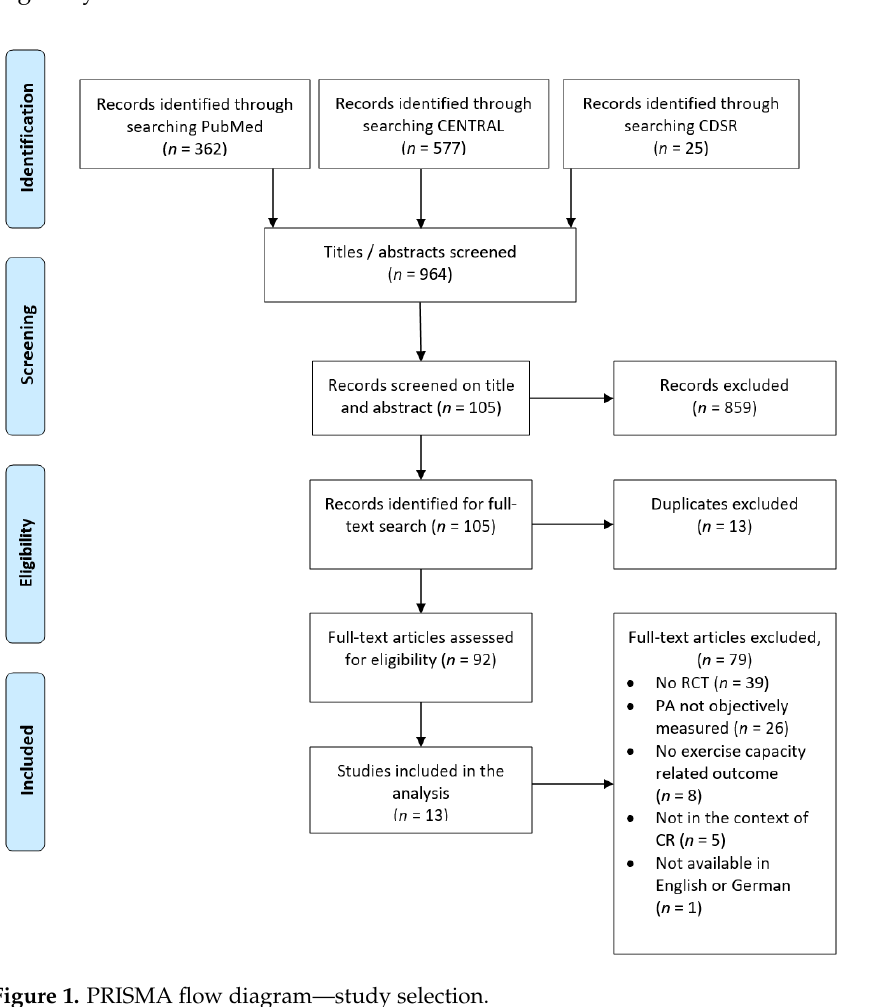
Figure 1. PRISMA flow diagram—study selection.